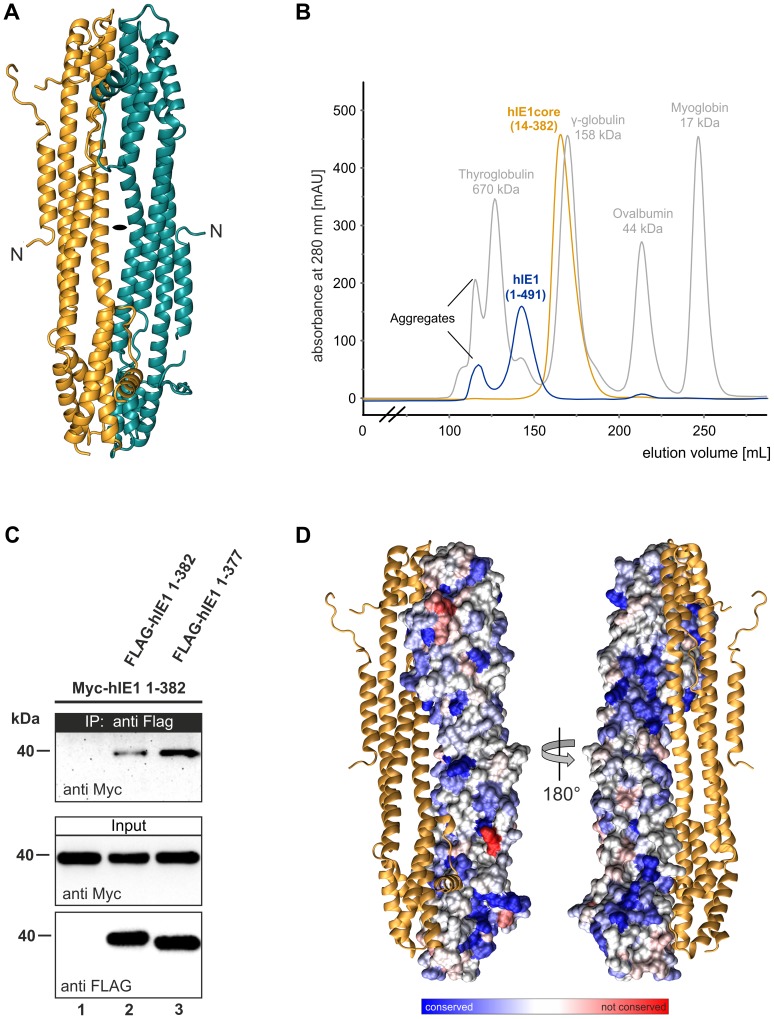
Oligomerization of IE1.(A) Dimeric assembly of rhIE1 in the crystal. The two monomers (in cyan and gold) are related by a local 2-fold rotation axis indicated by a black ellipse. (B) Self-association of recombinant IE1 and IE1CORE in gel filtration experiments. Overlay of the elution profiles of full length hIE1(1–491) (blue) and hIE1CORE(14–382) (gold). Full length hIE1 and hIE1CORE eluted as symmetric main peaks with apparent molecular weights of ∼390 kDa and ∼194 kDa, respectively. It currently remains unclear whether the elution behavior of hIE1CORE merely reflects the elongated molecular shape of the dimer as observed in the crystal structure of rhIE1CORE or whether hIE1CORE assembles in solution into oligomers that comprise more than two molecules. Molecular weight estimates are based on commercially available calibration proteins, as indicated by the grey curve. (C) Self-interaction of the IE1CORE in human cells. HEK293T cells were co-transfected with expression plasmids encoding Myc-tagged hIE1(1–382) and FLAG-tagged hIE1 variants comprising residues 1–382 or 1–377. After cell lysis, immunoprecipitation was performed with an anti-FLAG antibody. Proteins within the cell lysate (input) and co-precipitated PML (IP) were analyzed by Western blotting as indicated. (D) Evolutionary sequence conservation of IE1 mapped onto the surface of rhIE1. The chains of dimeric rhIE1 are shown in space-filled and ribbon representation, respectively. Residues are colored according to their degree of conservation ranging from highly conserved (dark blue) to highly variable (red). The two views differ by a rotation of 180° around a vertical axis.